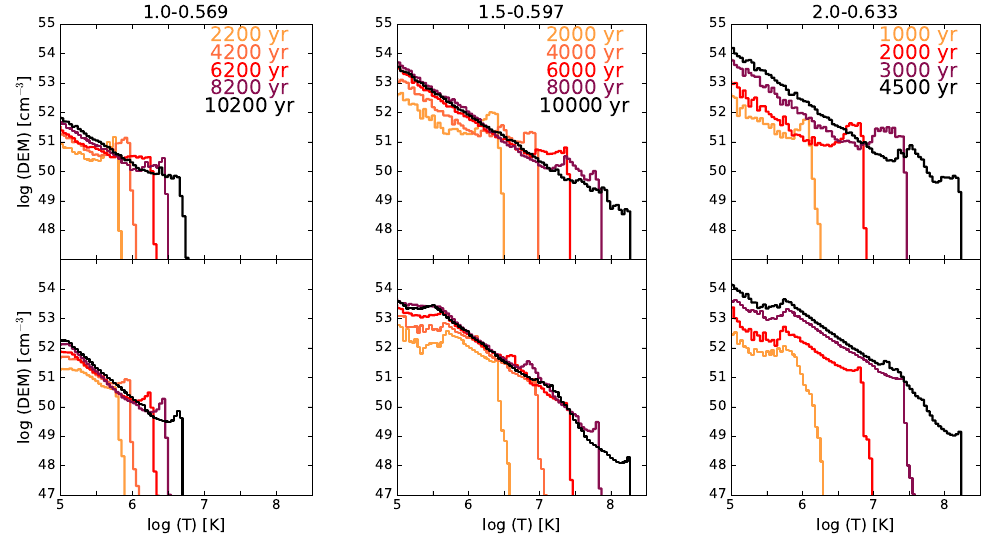
Figure 1. Evolution with time of the differential emission measure (DEM) of hot bubbles for the stellar models with initial masses of: 1 M (cid:12) ( left ); 1.5 M (cid:12) ( middle ); and 2.0 M (cid:12) ( right ). Upper and lower panels correspond to cases without and with thermal conduction, respectively. Times are marked with different colors. These panels have been taken from